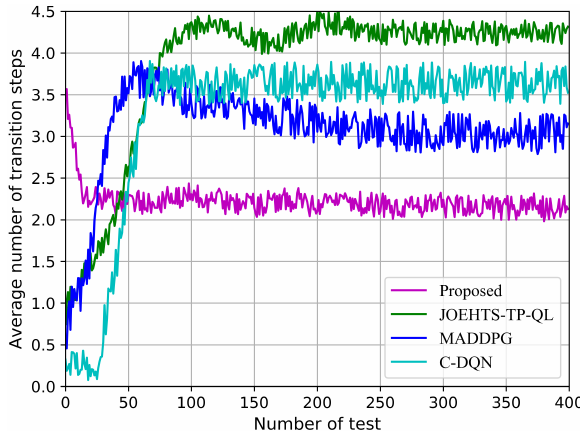
Figure 12. Average number of transition steps in each